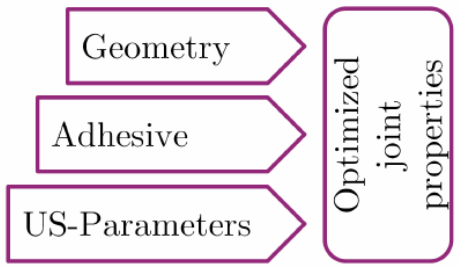
Figure 3. Approach for the optimization of the joint